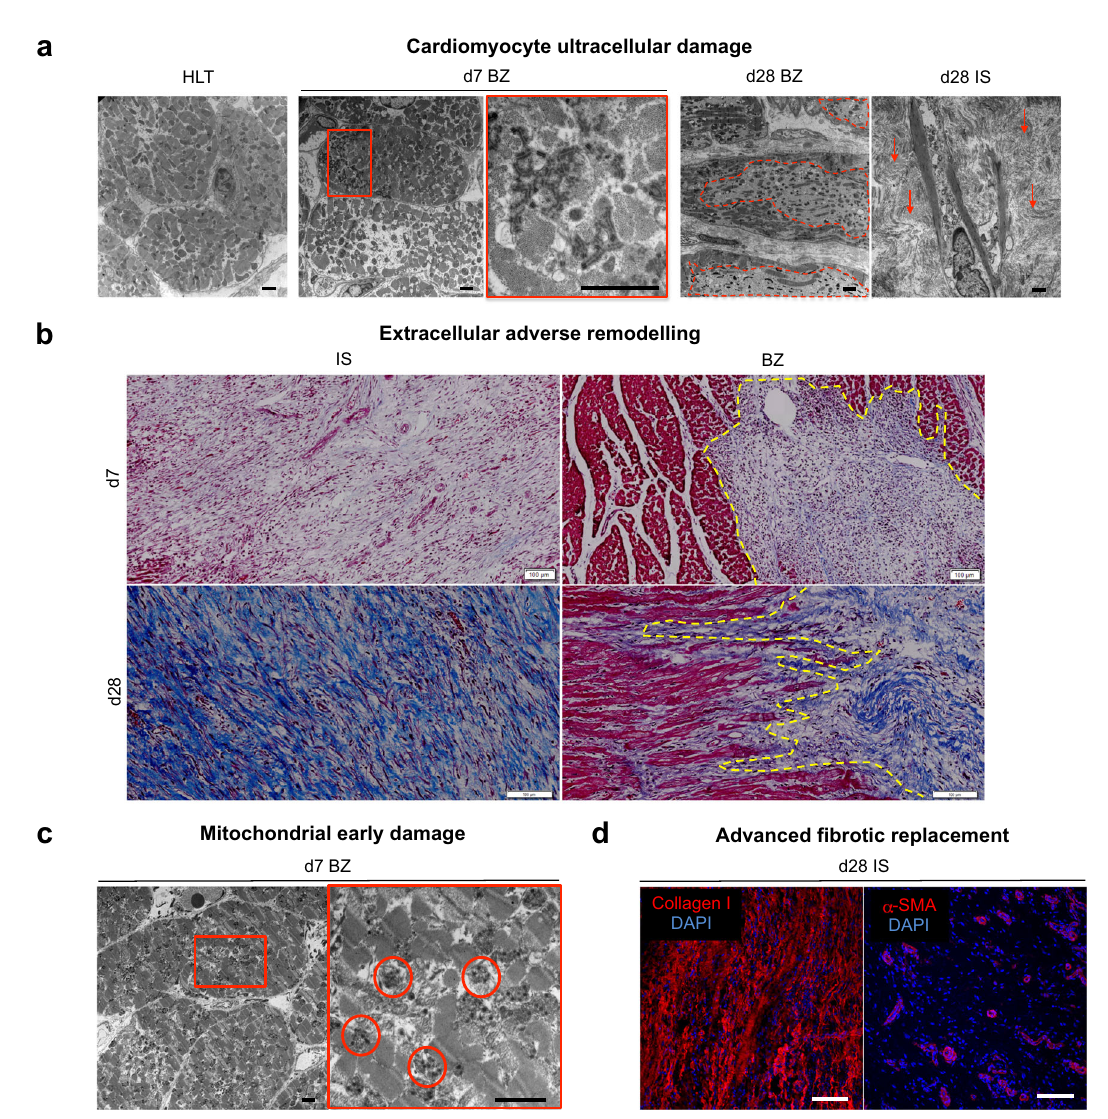
Fig. 2 | Ischaemic cellular damage and extracellular adverse remodelling fol- lowingNSTEMI. a Representative TEM micrographs showing ultracellular damage from healthy (HLT, far left) to border zone (BZ) cardiomyocytes starting from intercalated disks disruption on d7 post-NSTEMI (centre, with inset), to extended vacuolisation (dashed red line) on d28 post-NSTEMI (right), surrounded by col- lagen deposition (arrows) by myo fi broblasts in ischaemic core (IS). n =5 HLT and d7, n =7 d28 animals. Scale bars, 2 µ m. b Representative Masson ’ s Trichrome